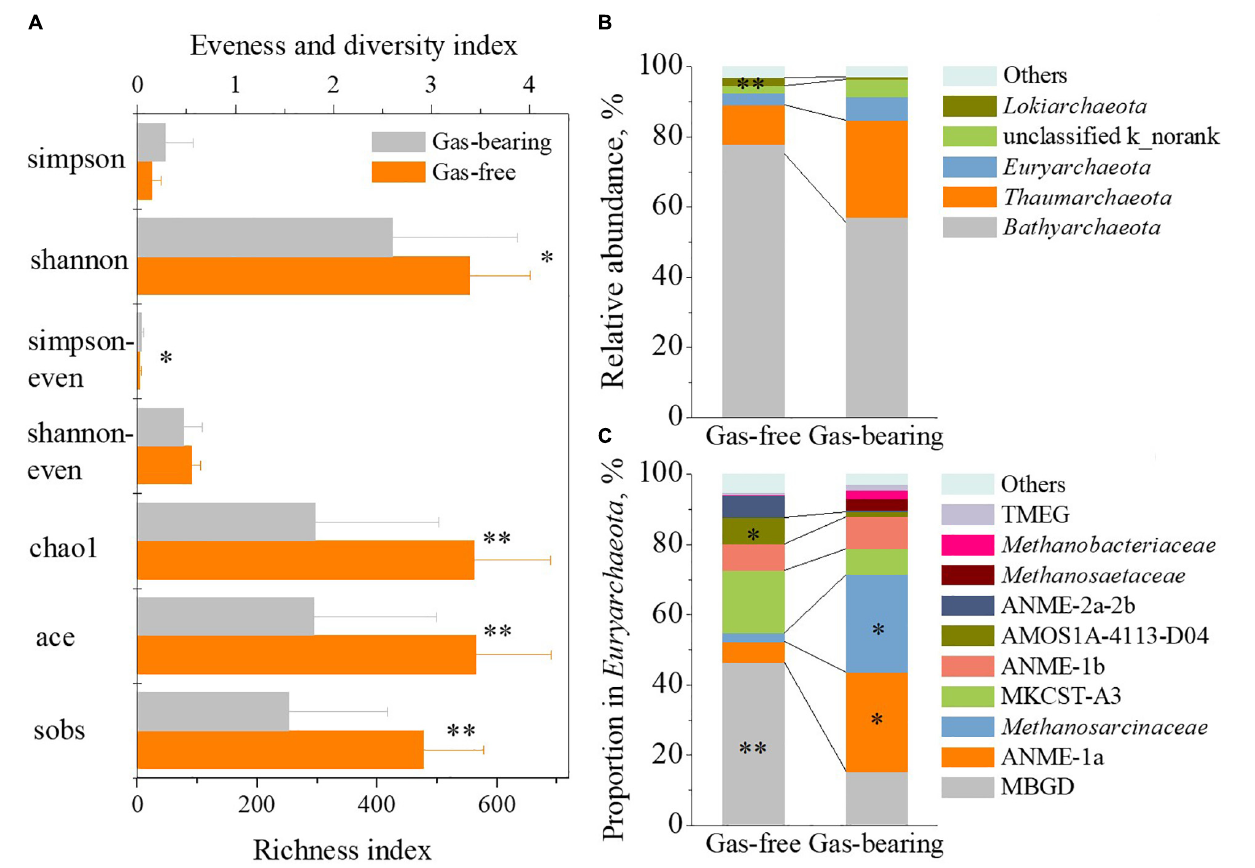
FIGURE 5 | The difference of archaeal community between strata with shallow gas or not. The difference of α -diversity indexes (A) , relative abundance of archaeal phylum (B) and proportion in Euryarchaeota at family level (C) between gas-bearing layers and gas-free layers (asterisk: the level of significance. “ ∗ ” represents p < 0.05, “ ∗∗ ” represents p <